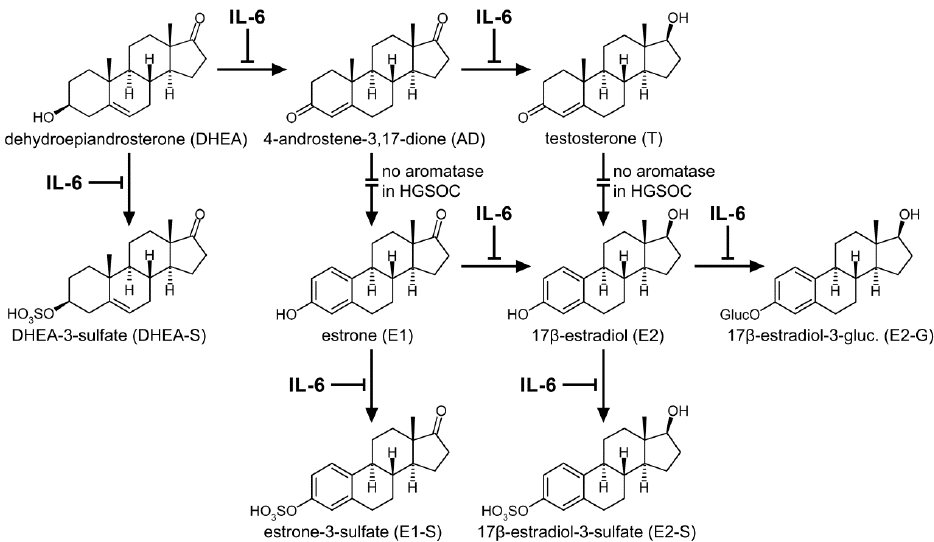
Figure 6. Interaction of IL-6 with the estrogen synthesis and metabolism in HGSOC. IL-6 influences several key steps in the formation of estrogen precursors, active estrogens, and their respective conjugates leading to decreased levels of steroid metabolites. By contrast, treatment with the anti-IL-6 antibody TCZ can antagonize this e ff ect, thereby, stimulating the biotransformation of estrogens. Intersected arrows indicate no expression of aromatase ( CYP19A1 ) in HGSOC